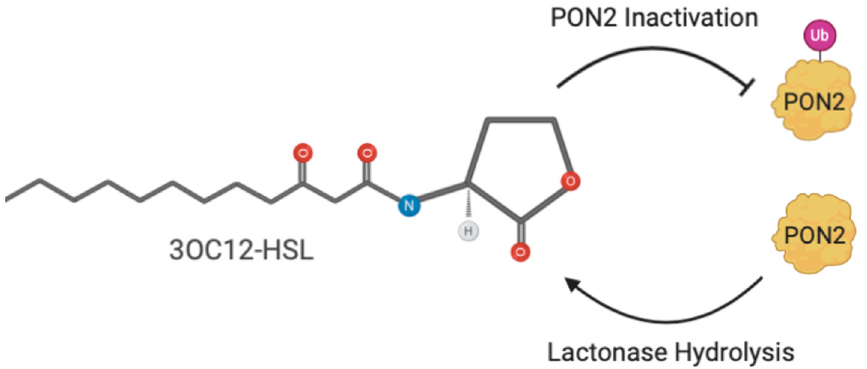
Figure 6. 3OC12-HSL induction of PON2 ubiquitination. The molecule 3OC12-HSL induces PON2 Lys 144 ubiquitination with subsequent downregulation and decrease of PON2 lactonase